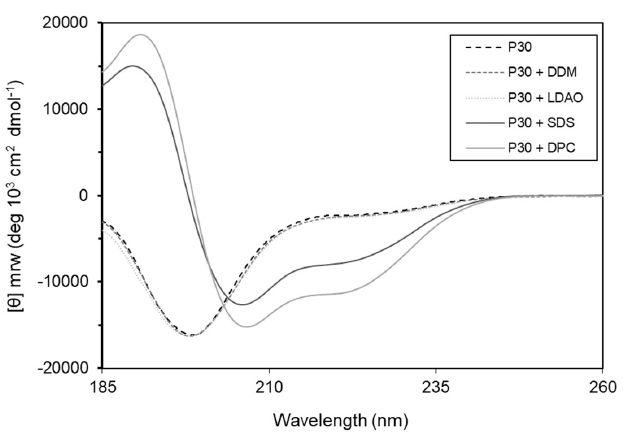
Figure 9. Circular dichroism spectra of P30 peptide show α -helical conformation of Intestinalin (P30) in the presence of detergents SDS and DPC (solid lines). Without addition of detergents or in the presence of DDM or LDAO (dotted lines) Intestinalin is in a randomly coiled state; DDM: lauryl- β - d -maltoside; DPC: n -dodecylphosphocholine; SDS: sodium dodecyl sulfate; LDAO: lauryldimethylamine N